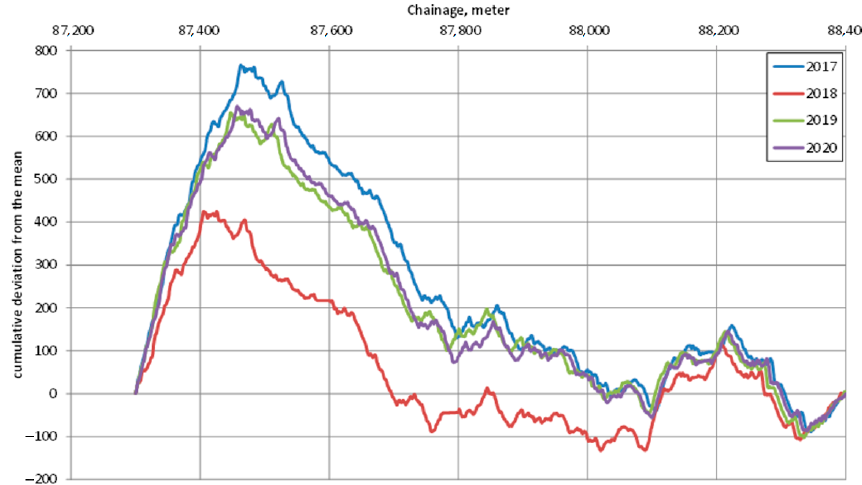
Figure 4. Cumulative deviation from the mean (section No. 2).